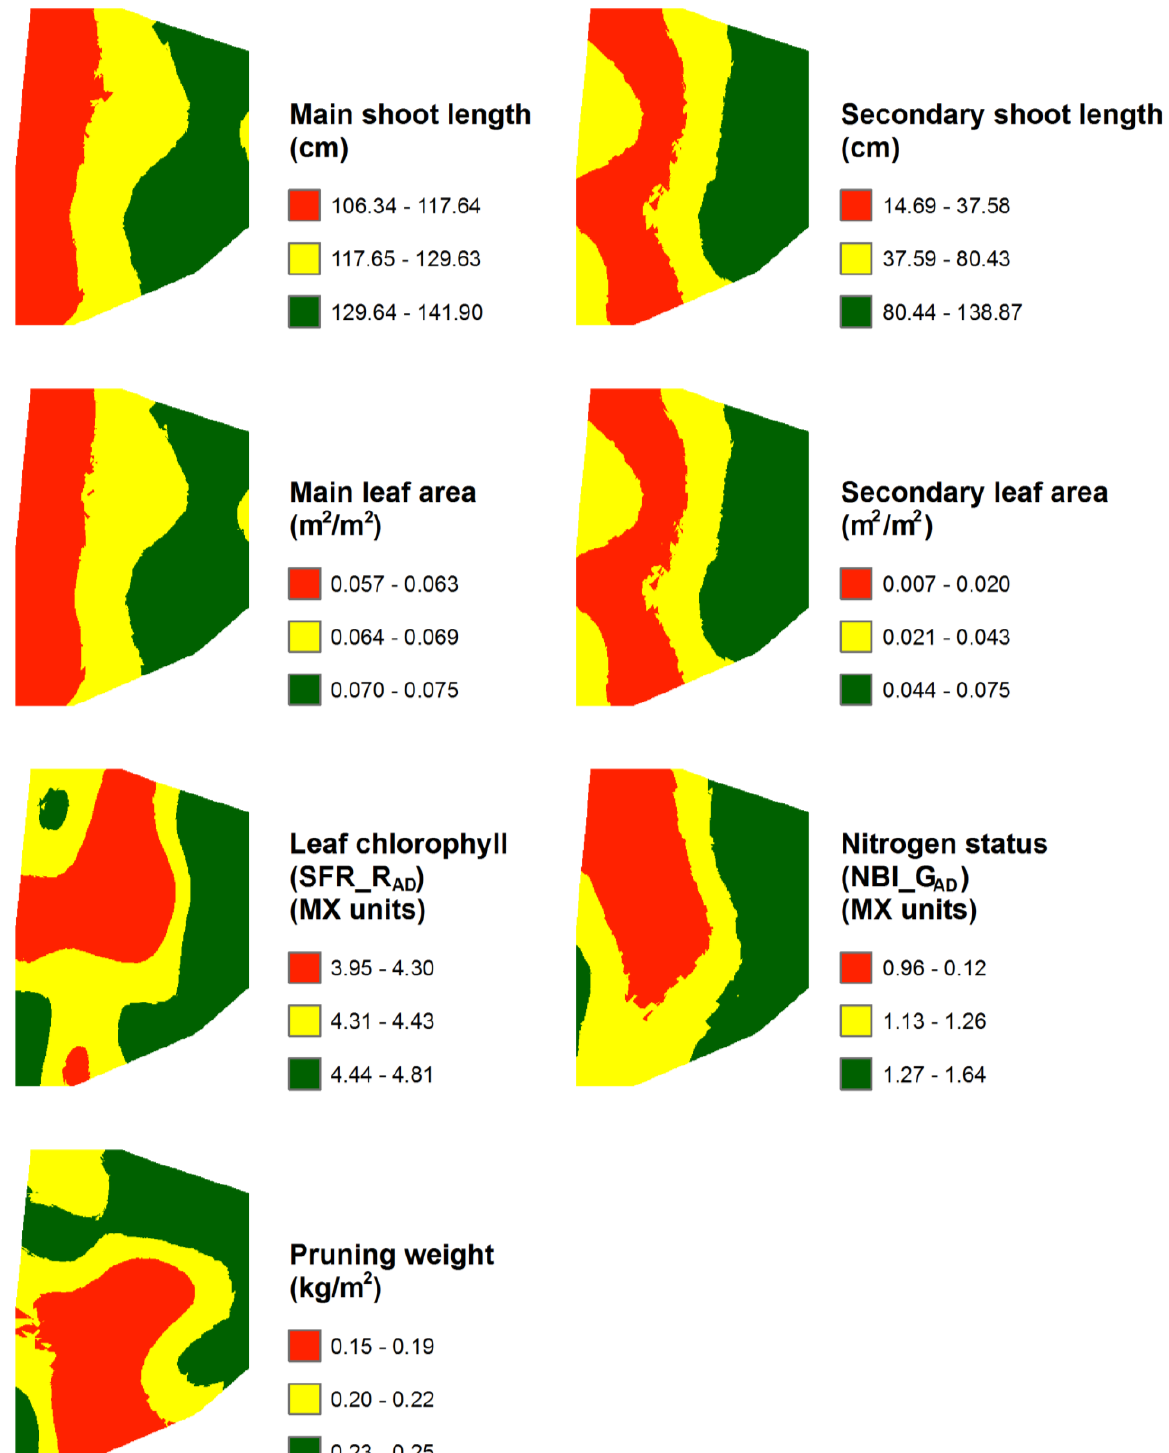
Figure 4. Maps obtained for vegetative variables (pruning weight per vine, main shoot length, secondary shoot length, mail leaf area per shoot and secondary leaf area per shoot, leaf chlorophyll content (SFR_R AD ) and nitrogen balance index (NBI_G AD )) in a Tempranillo ( Vitis vinifera L.) vineyard. Maps were represented by